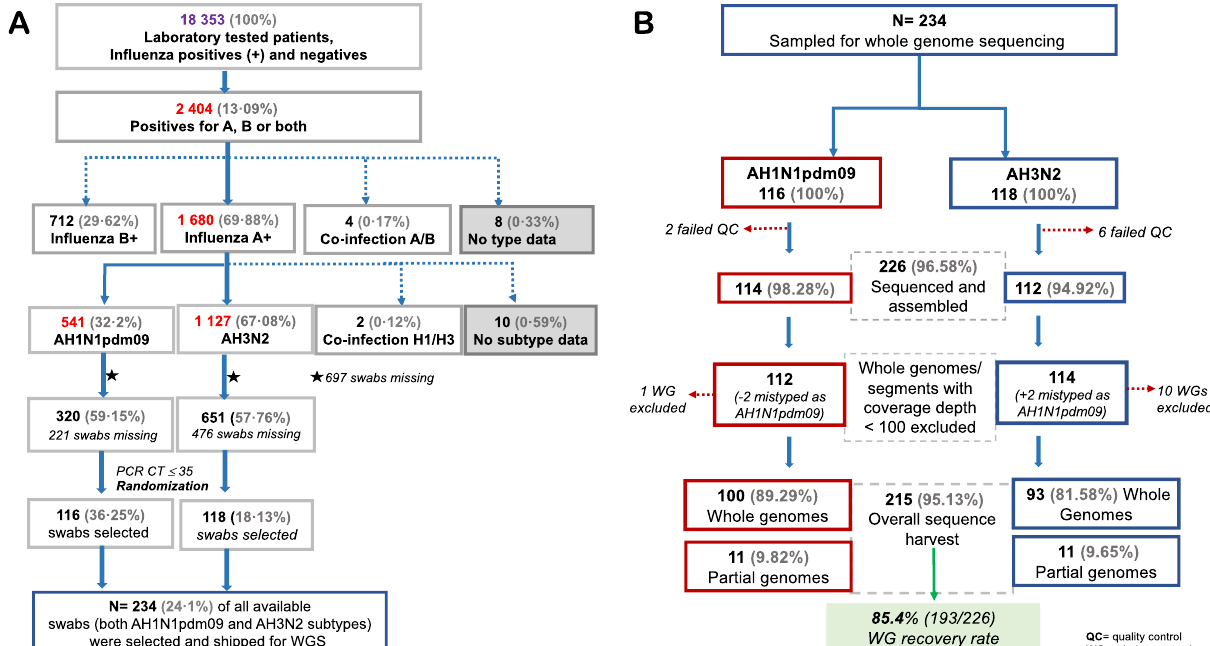
Figure 1. Workflow of swab selection and whole genome recovery. ( A ) Shows how swabs were selected for influenza whole-genome sequencing (WGS). Patients diagnosed with either influenza subtypes A(H1N1) pdm09 or A(H3N2) and whose swab had a PCR CT ≤ 35 had their laboratory codes randomised based on the subtype and year of collection using the R software v3.6.3 (https:// www.r- proje ct. org). All available swabs were retrieved for years with less than fifteen swabs. The 697 swabs missing include some shipped to the Centers for Disease Control and Prevention (CDC) for routine surveillance and some lost due to an accidental failure of a freezer. The numbers are based on the UVRI-NIC laboratory dataset only, as of 9th May 2018. ( B ) Shows how viral samples were excluded before and after sequencing and the rate of whole genome recovery. Eight viruses [2 A(H1N1)pdm09 and 6 A(H3N2)] failed quality control (QC) before